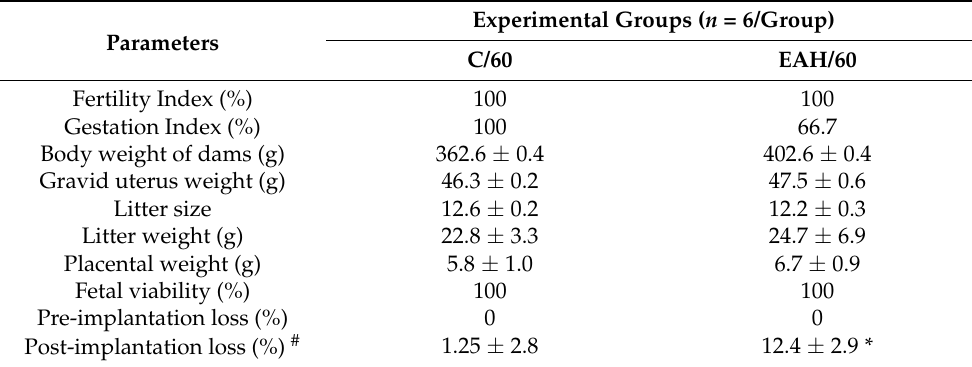
Table 5. Effect of Agave sisalana on the reproductive and fetal parameters.